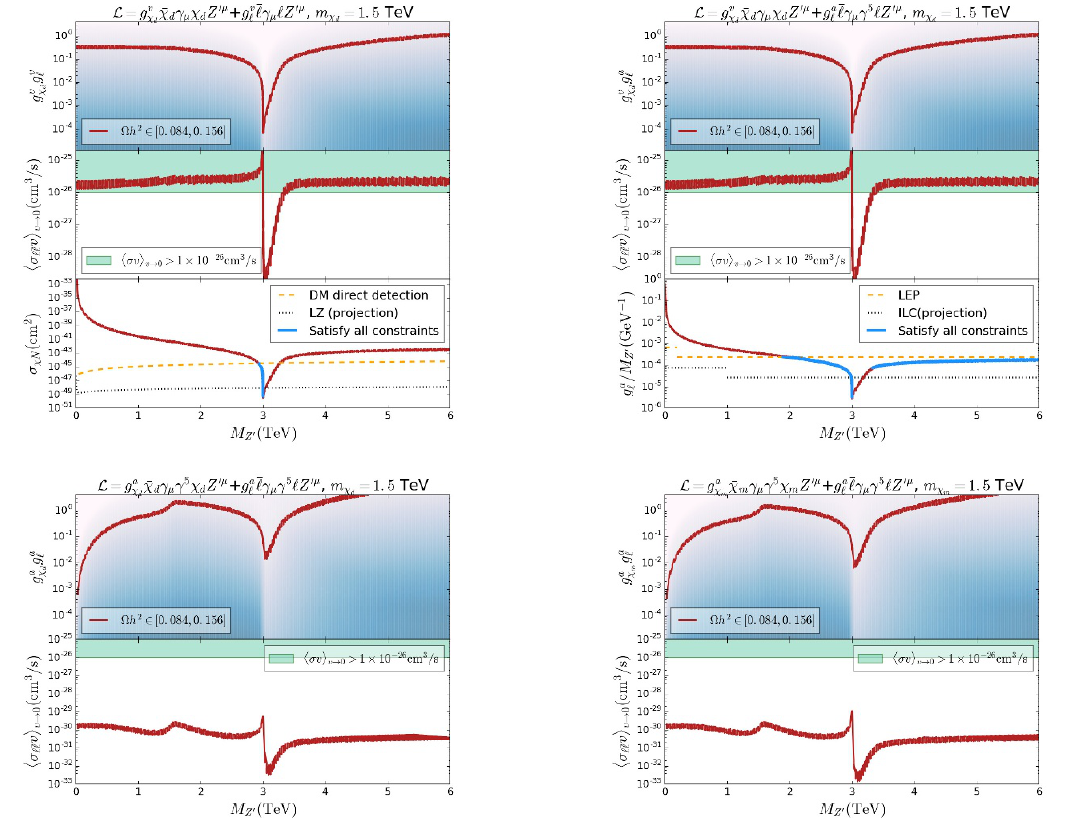
Figure 3 . A vector mediator vector coupled to Dirac fermion DM (top), axial-vector to Dirac fermion DM (bottom left) and Majorana fermion DM (bottom right). The mediator coupling with leptons is vector (top left) or axial-vector (others). Each panel shows DM properties as a function of mediator mass. The blue color gradient in the (cid:12)rst panel shows relic density, where darker blue means greater relic